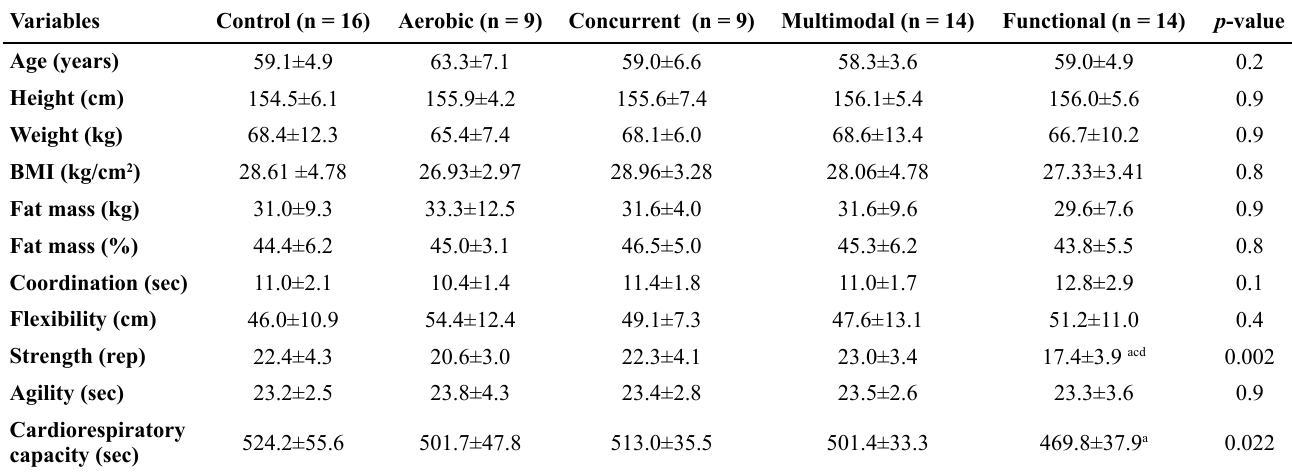
Table 1. General characteristics of the groups at baseline.